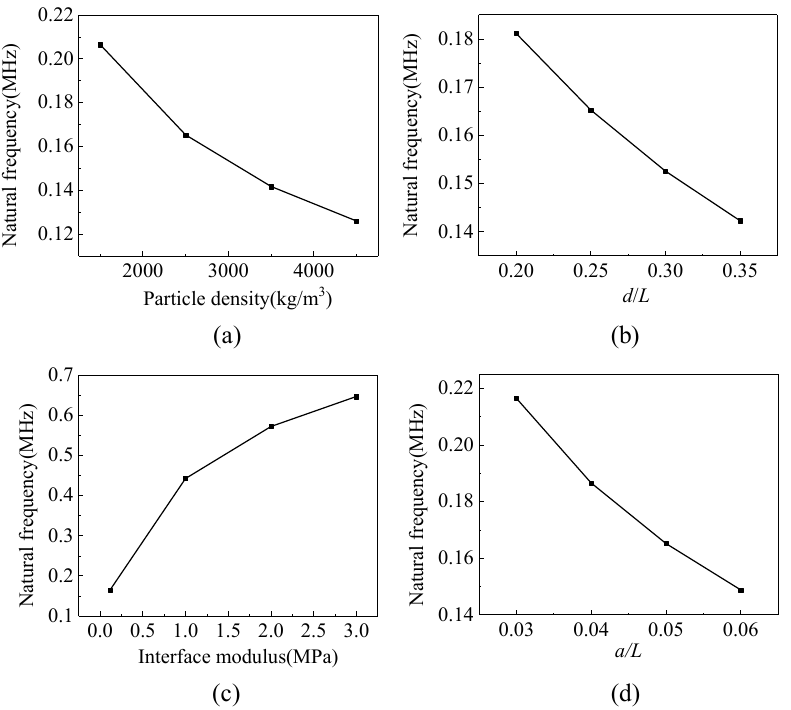
Figure 4. The effects of ( a ) particle density, ( b ) particle diameter, ( c ) interface Young’s modulus of the coating, and ( d ) thickness of the coating on the natural frequency.